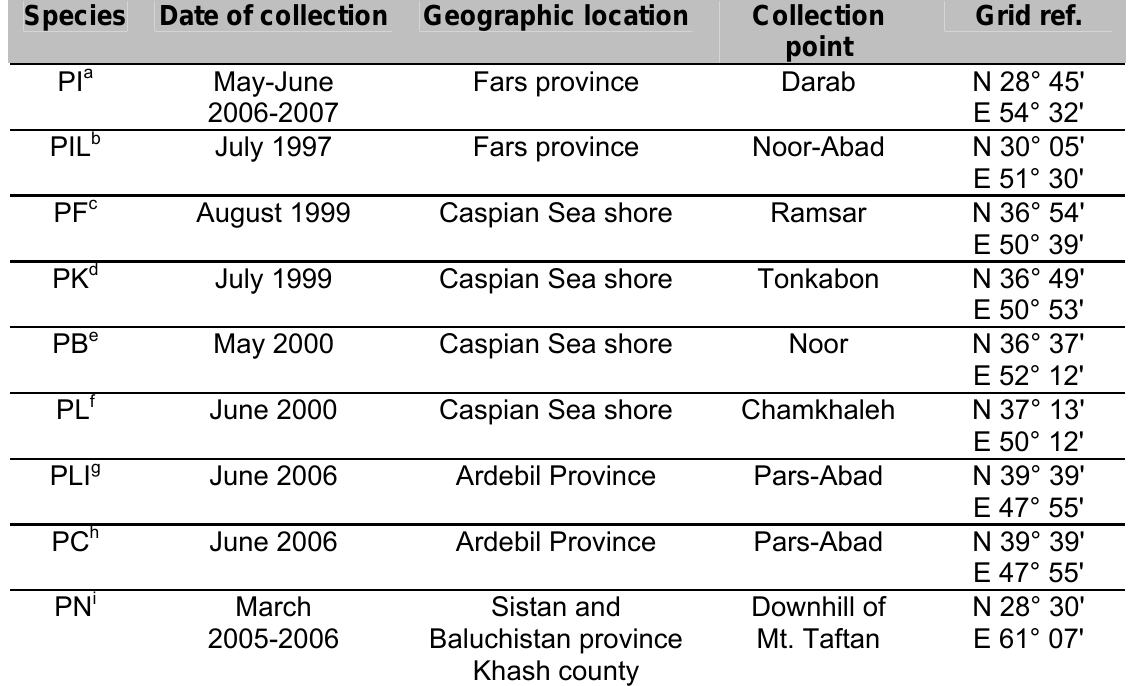
Table 2. Paederus beetles (Coleoptera: Staphylinidae) in Iran: faunal diversity and collection localities of reported dermal lesions